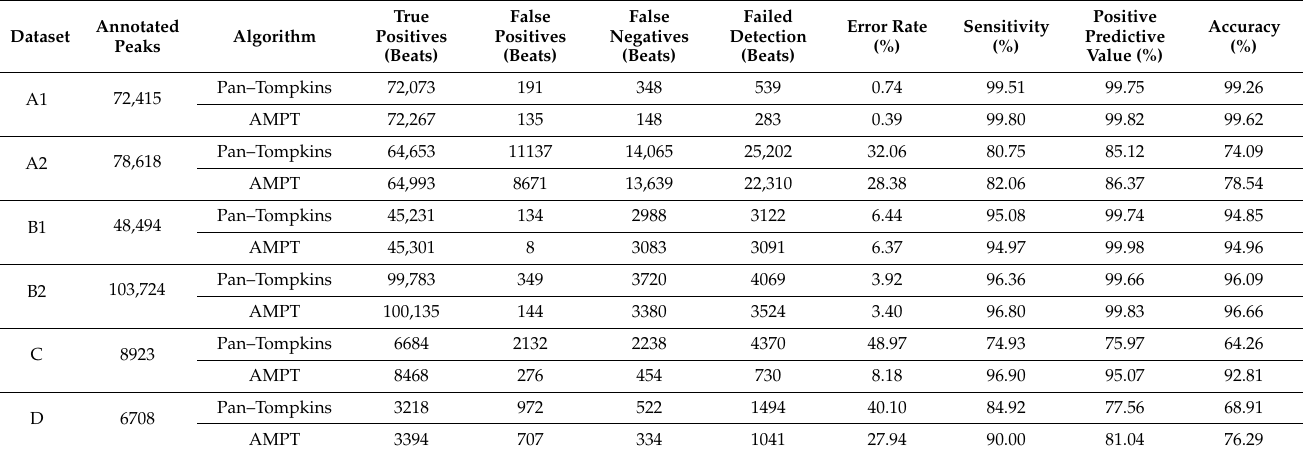
Table 2. Correctness of the Pan–Tompkins and AMPT algorithms by dataset. A1 = High Qual- ity, A2 = Low Quality, B1 = Normal Sinus Rhythm, B2 = Arrhythmias, C = Paced Rhythm, and D = TeleHealth